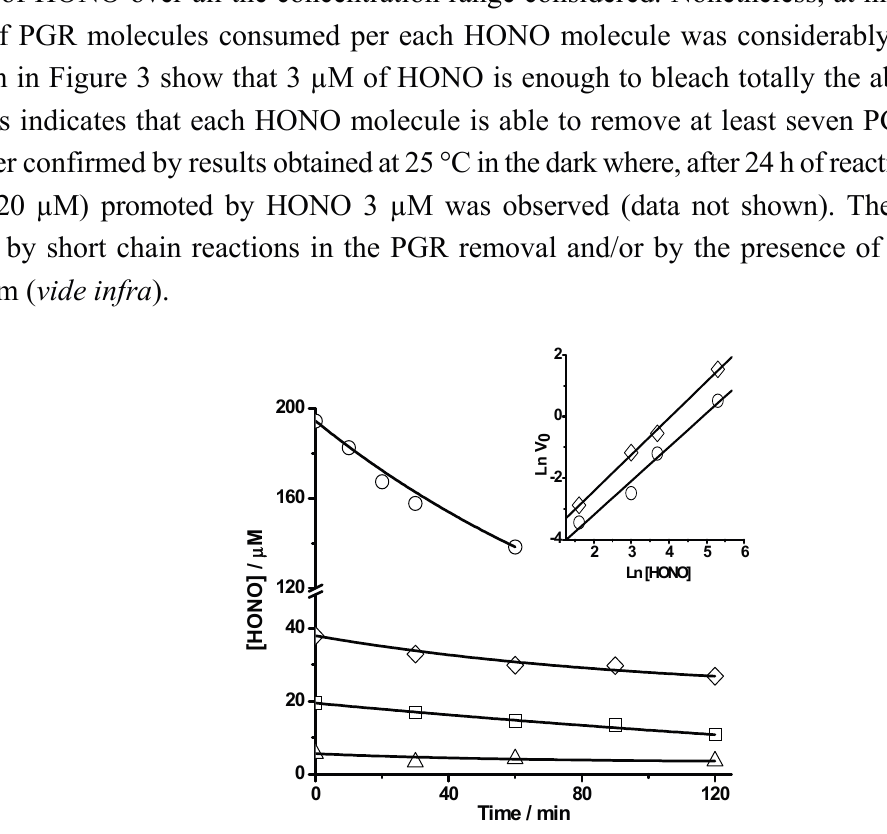
Figure 4. Consumption of HONO during the PGR-HONO reaction. PGR (20 µM) was incubated with HONO at 5 µM ( Δ ), 20 µM ( □ ), 40 µM ( ◊ ), and 200 µM ( ○ ) in SGM. The HONO concentration was determined according to Griess assay. Temperature = 25 °C. Inset: Ln(initial reaction rate, V 0 ) vs. Ln[HONO] 0 plot. V 0 was measured by the consumption of PGR ( ◊ ) and HONO ( ○